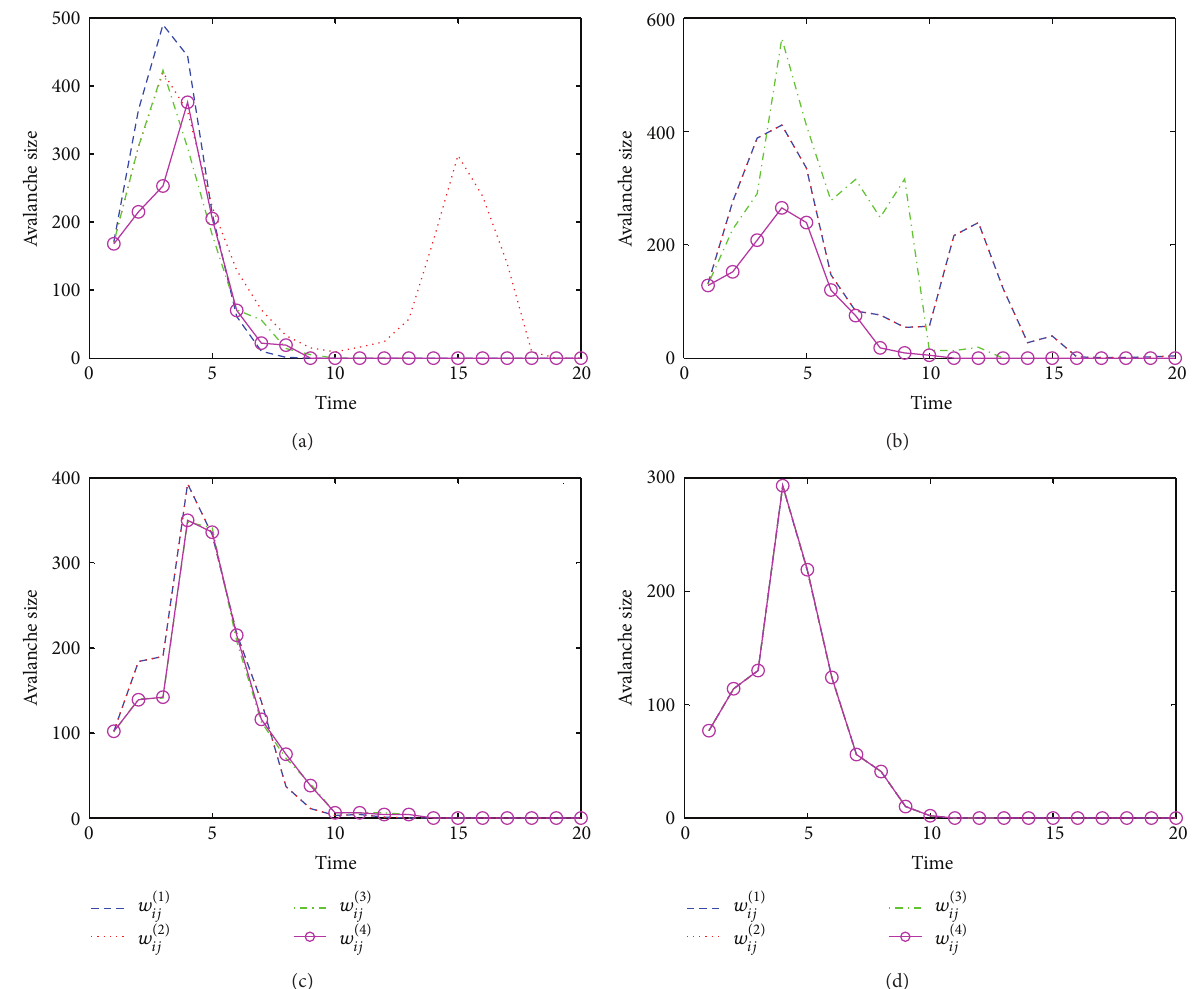
(𝑡) in each time step 𝑡 as a function of 𝑡 for (a) 𝛼 = 0.02 , (b) ae